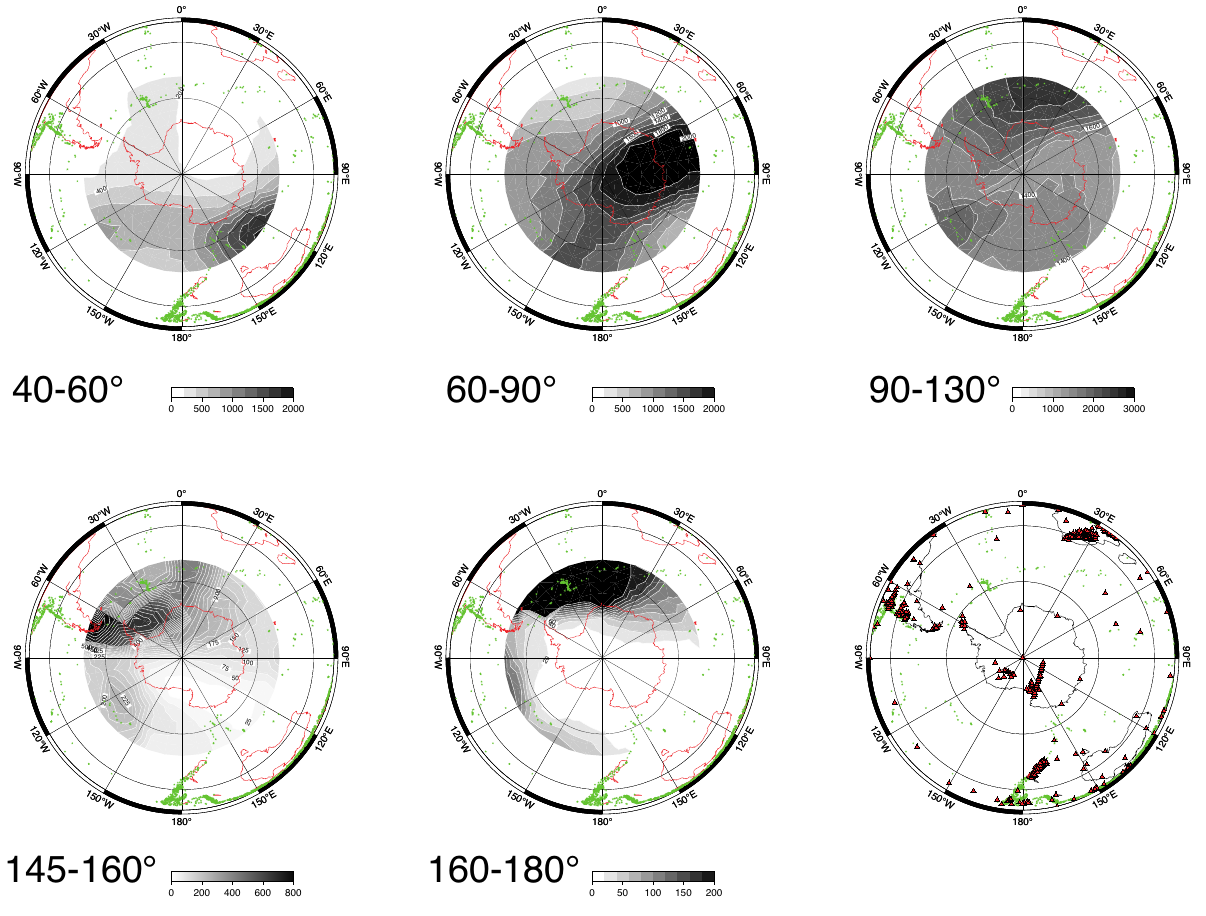
Figure 3. Geographical distribution of teleseismic event numbers (gray horizontal scales) observed at each location in the Antarctic for epicen- tral distances of 40-60°, 60-90° and 90-130° (from left to right in upper row), 140-160° and 160-180° (in lower row), respectively. A list including global distributed earthquakes is used for counting with magnitude mb greater than or equal to 5.5 for the period of 1990-2004. Epicenters are represented by green dots. (lower right); red triangles are the permanent and temporary stations in Antarctica from IRIS/GSN and